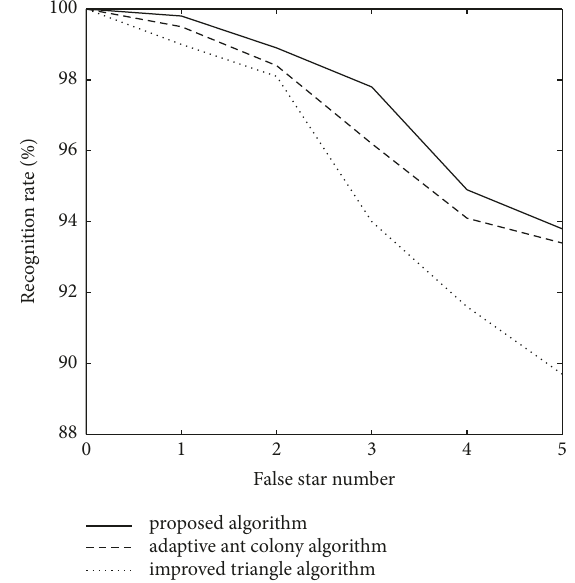
Figure 6: Recognition results under false star